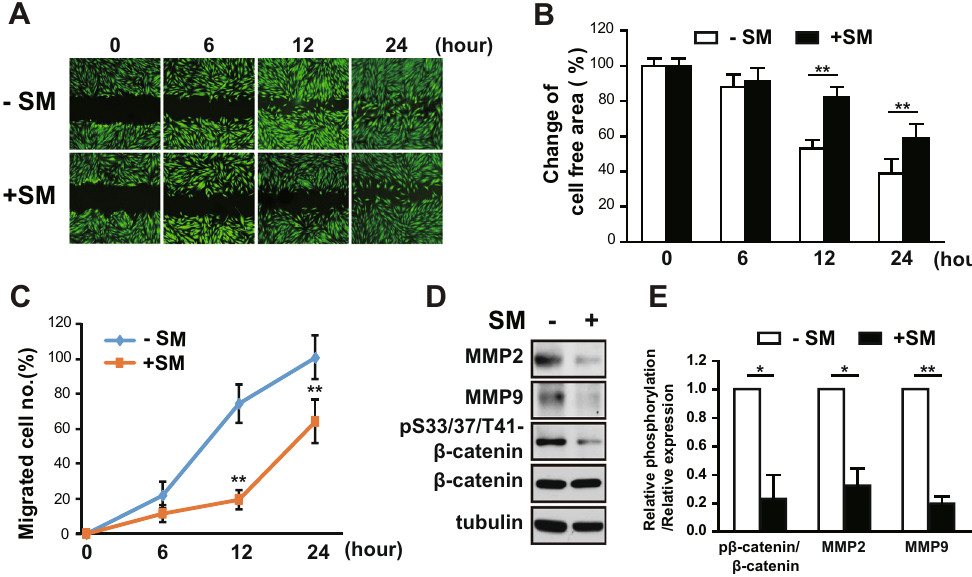
Figure 2. SM impedes the migration of human eSCs. ( A – C ) Human eSCs were scratched with a T200 tip and then incubated under 1 g or SM for the indicated times. ( A ) Cells were stained using the CytoPainter Cell Tracking Staining Kit and photographed. ( B ) The cell-free area was measured using ImageJ and change of cell-free area was calculated. ( C ) The number of migrated cells was counted using ImageJ. ( D ) The cells were incubated either under terrestrial gravity (1 g ) or under SM for 36 h, lysed, and analyzed by western blotting. ( E ) Western blot images were analyzed using ImageJ to determine the relative protein expression of MMP-2 and MMP-9 (using tubulin as the internal control) and the relative phosphorylation of S33/37/T41- β -catenin (using β -catenin as the internal control). Abbreviations: simulated microgravity (SM). Data are expressed as mean ± SD, with paired t -tests performed as indicated. ** P < 0.01, * P < 0.05 versus control at each indicated